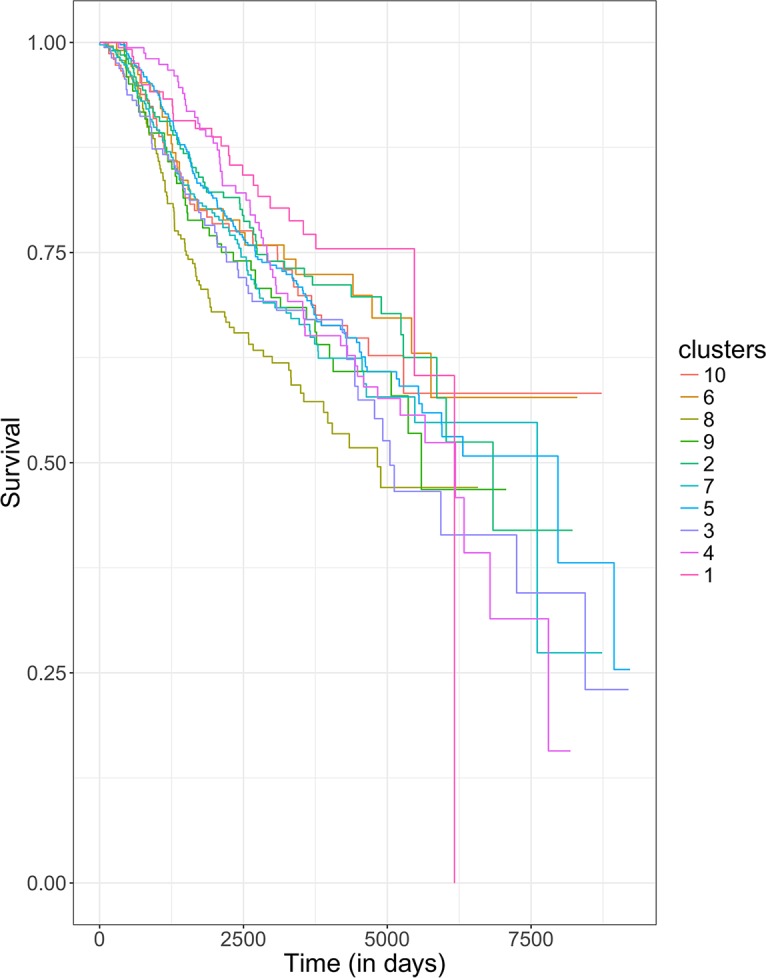
Clustering breast cancer samples based on their functional activity profile.Kaplan-Meier survival curves of patients grouped in the 10 clusters show significant survival differences.